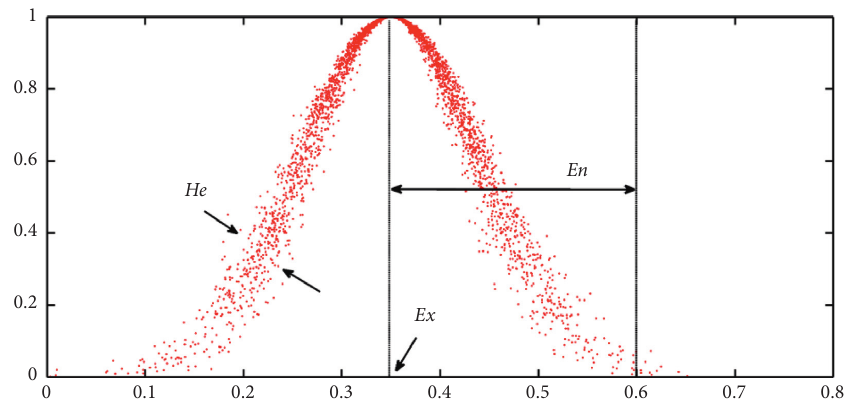
Figure 3: Diagram of forward cloud